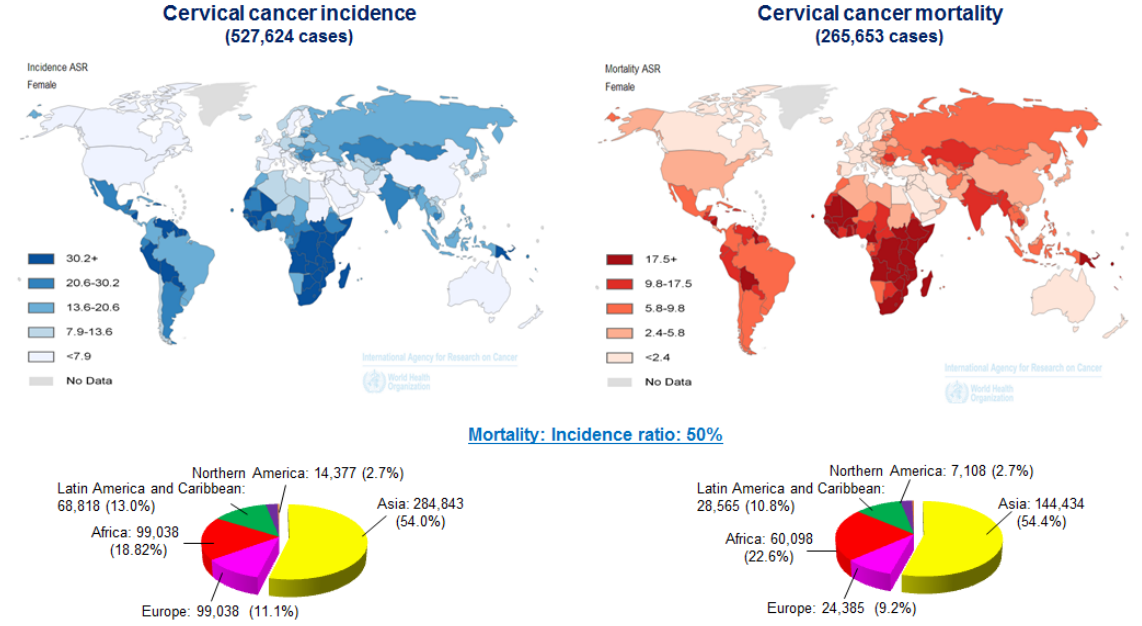
Figure 1. Worldwide cervical cancer incidence and mortality in 2012. Geographical distribution of cervical cancer incidence ( left) and mortality ( right ) worldwide. Approximately 85% of cases occur in developing countries. Mortality: incidence rate ratios for cervical cancer were obtained from GLOBCAN